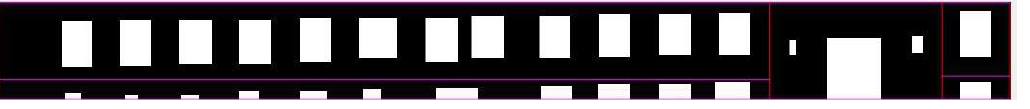
Figure 8. Detected floors using vertical and horizontal